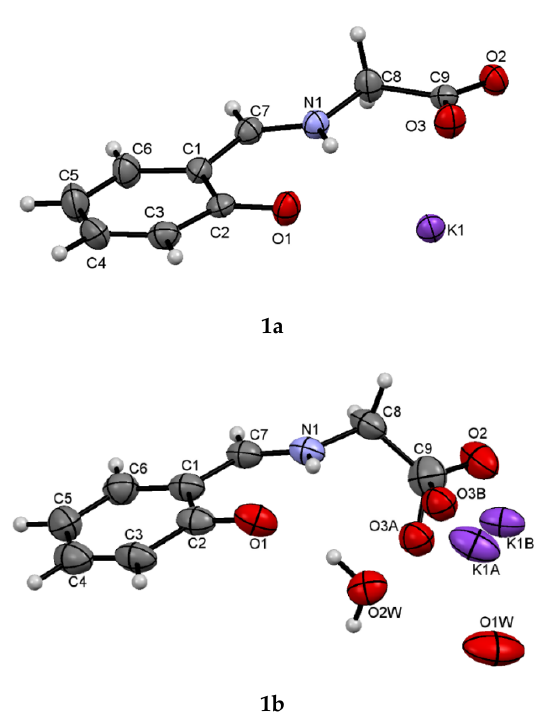
Figure 1. Molecular structures of compounds 1a and 1b showing the atom-labeling scheme. Displacement ellipsoids are drawn at the 50% probability level.